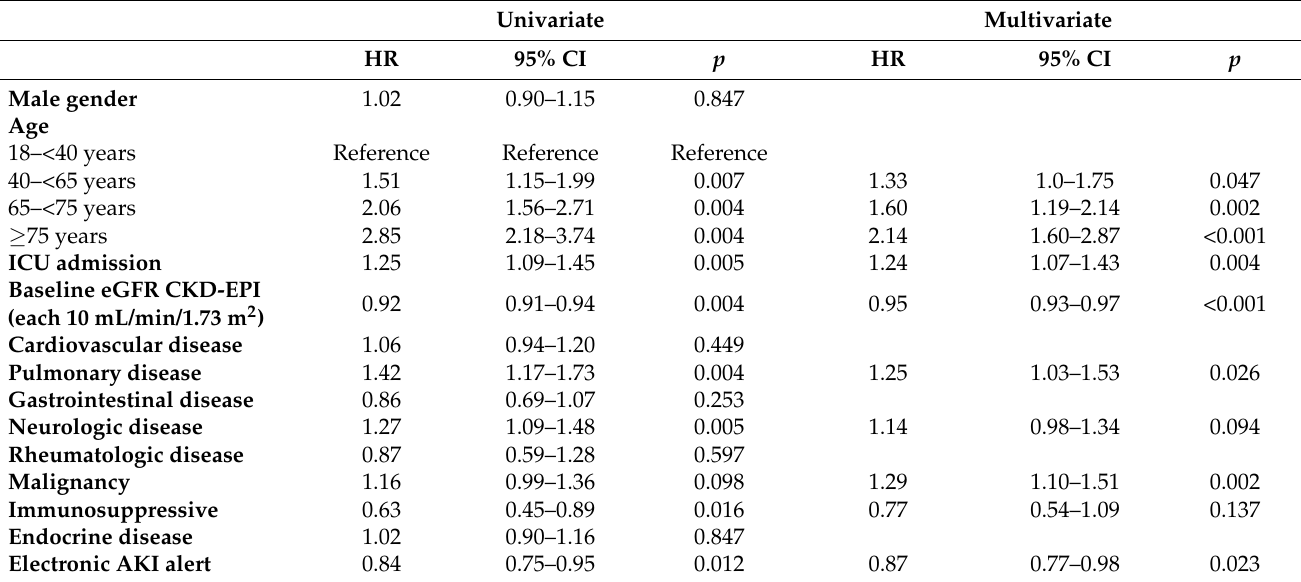
Table 4. Cox univariate and multivariate proportional hazard models: 30-day